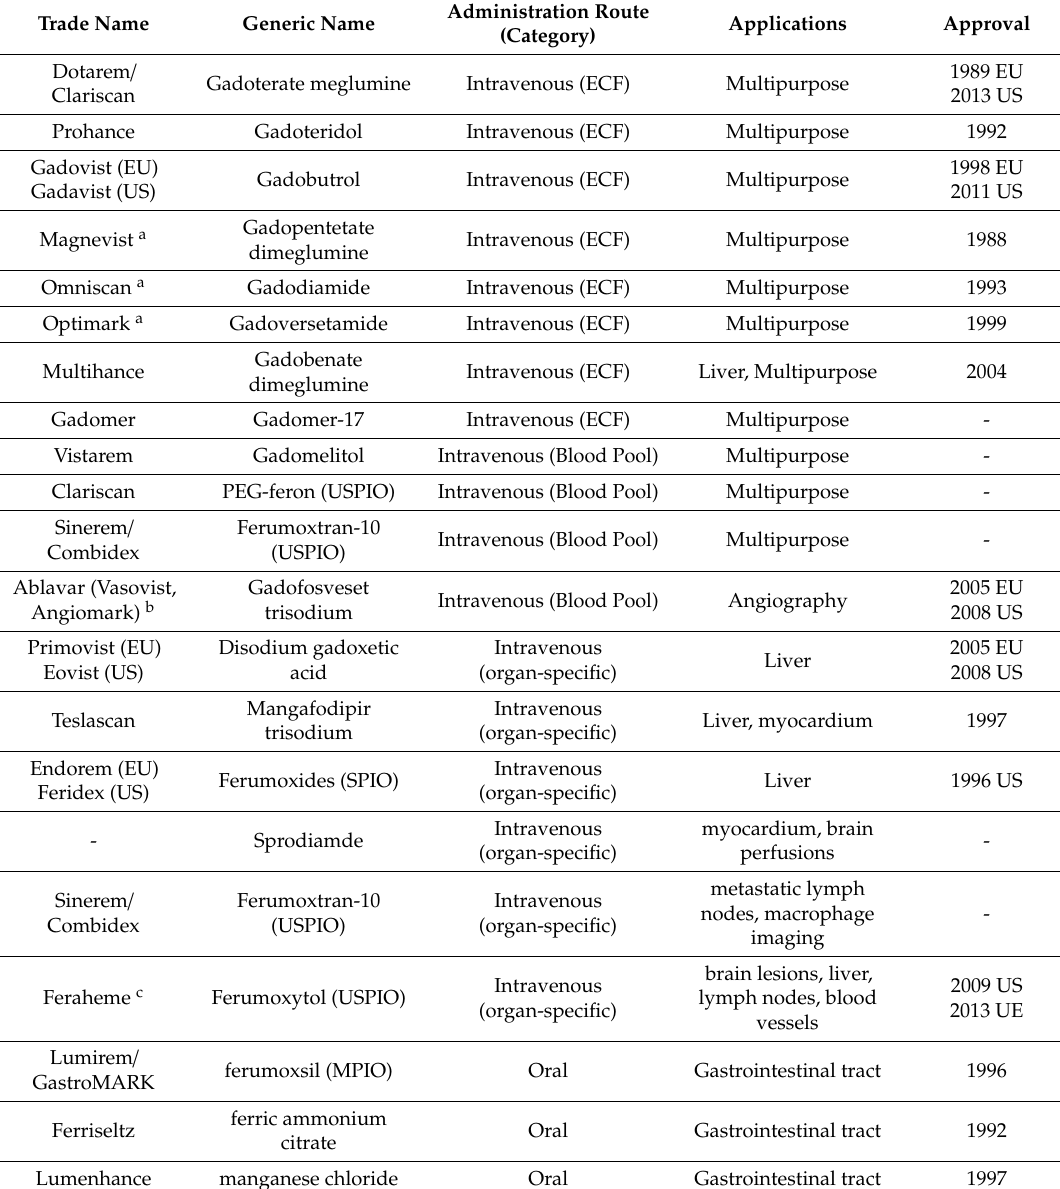
Table 1. Commercially-approved contrast agents and some examples that have received approval for clinical trials